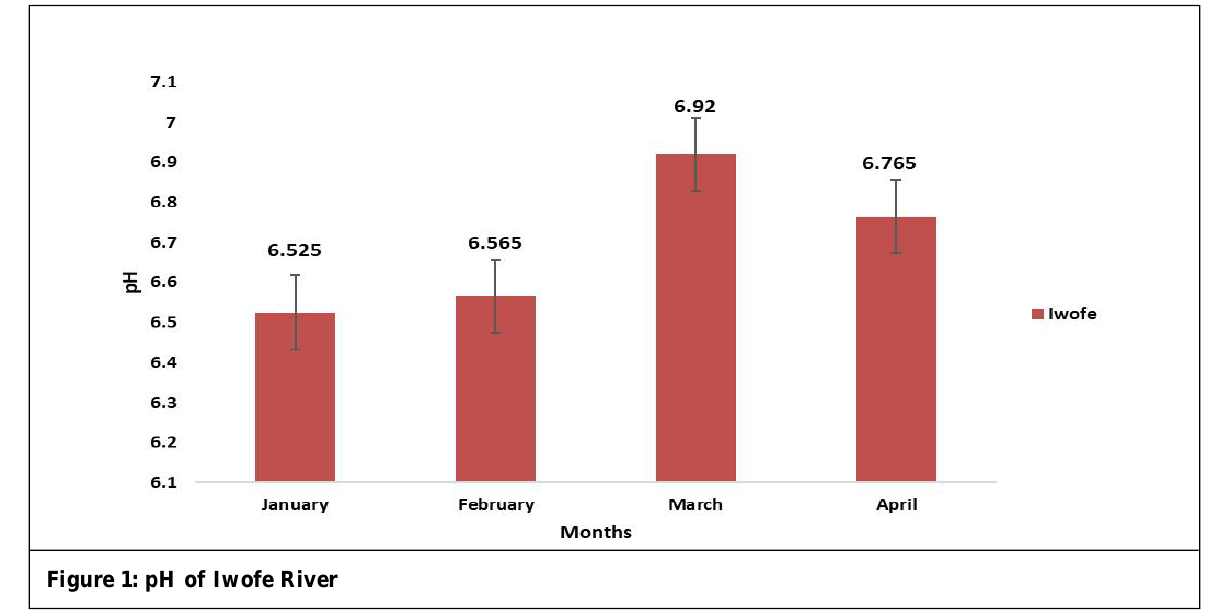
Figure 1: pH of Iwofe River